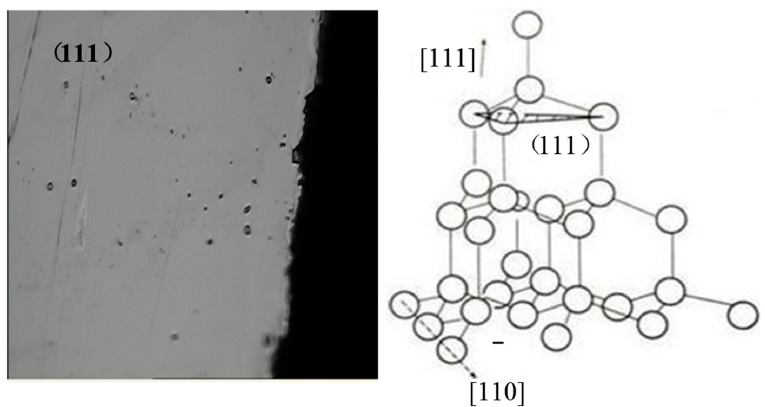
Figure 12. Transgranular cleavage failure section and structure.